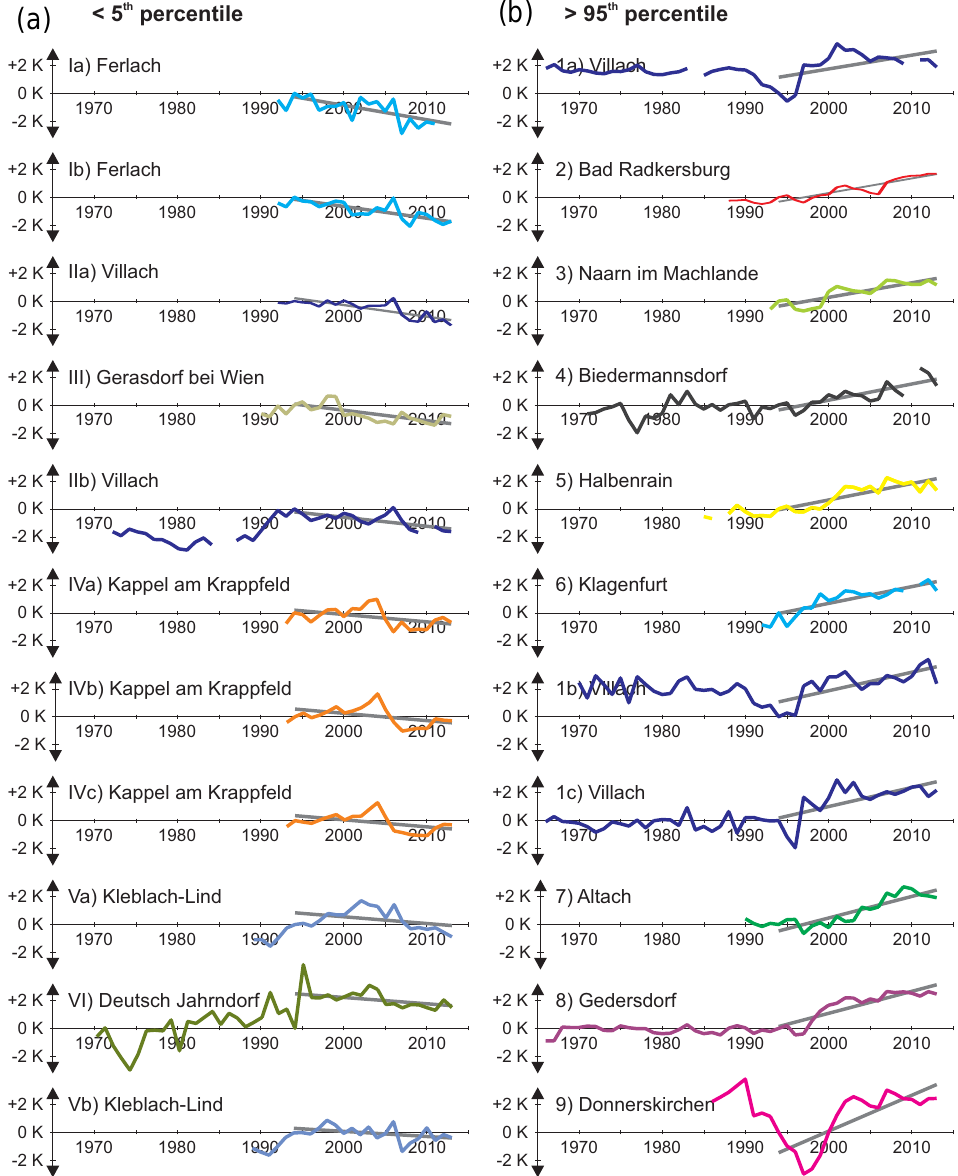
Figure 5. Annual mean time series and linear fit (in grey) of the wells with the lowest ( a , numbered with roman numerals) and highest ( b , numbered with arabic numbers) temperature changes in the timeframe 1994–2013. See Figs. S5 and S7 for an overview of the locations. They are placed in ascending order with the highest temperature change at the